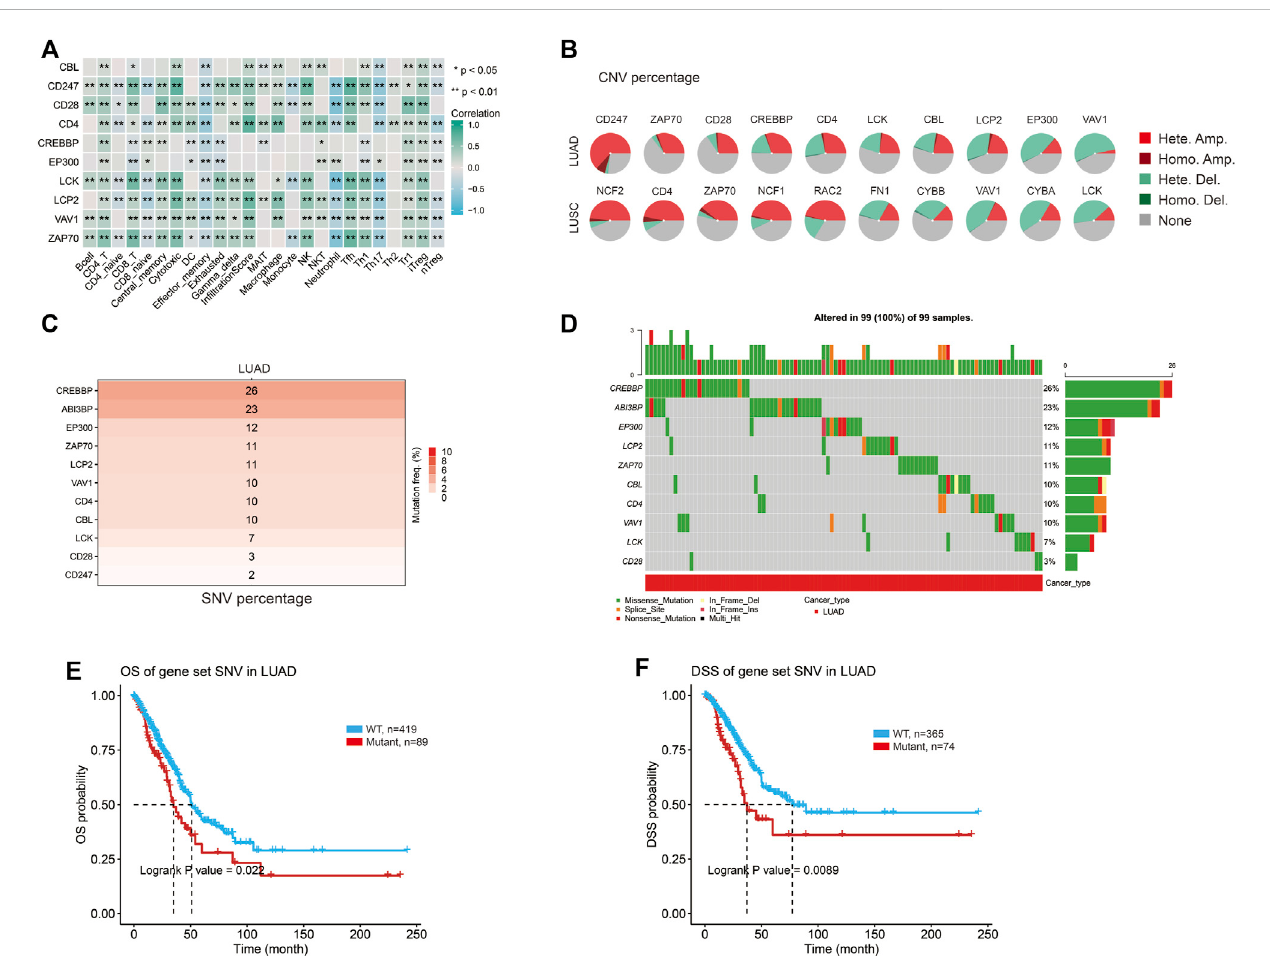
FIGURE 6 Thespeci fi cmutationofthehubgenes. (A) Relationshipbetweenthehubgenesandimmunecells. (B) TheCNVpercentageofhubgenesinlungcancer. (C) SNV mutation frequency of hub genes in LUAD. (D) Oncoplot provides the situation of the SNV of the hub genes in LUAD. OS (E) and DSS (F) of hub genes SNV in